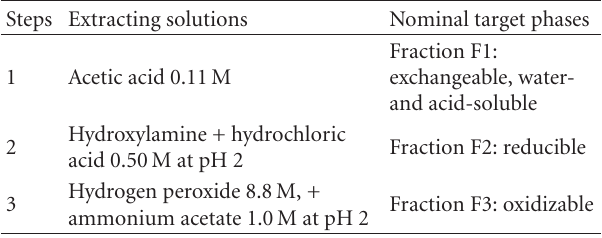
Table 1: Sequential extraction procedure (from Rauret et al. [33]).